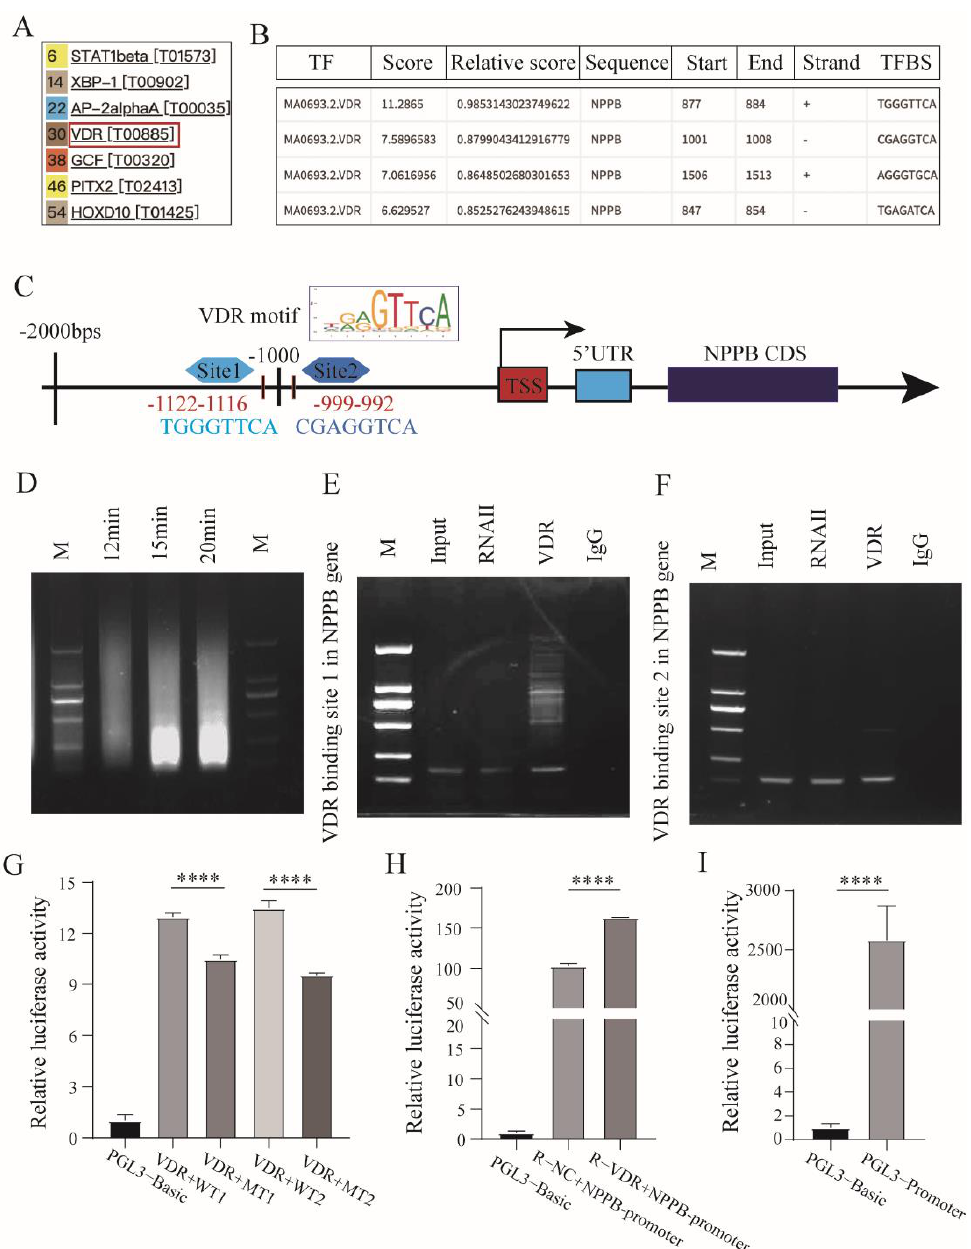
Figure 6. VDR binds to BNP promoters to regulate BNP gene expression. ( A ) Possible BNP binding transcription factors predicted by PROMO . ( B ) Predicted VDR binding sites in human BNP(NPPB) gene promoter regions. Human NPPB gene upstream regions were analyzed for VDR binding sites by JASPAR online analysis (http://jaspar.genereg.net, accessed on 14 April 2021). ( C ) Schematic diagram of predicted VDR binding sequences within a region 999 bp and 1122 upstream of the BNP gene locus TSS. ( D ) DNA fragments were obtained after different times of ultrasound before ChIP assays. ( E , F ) ChIP assays were performed to determine the binding of VDR to the BNP promoter region in 293 T cells. The two regions amplified by the specific PCR primers in ChIP assays are indicated. ( G – I ) Luciferase activity assays were conducted to assess the interaction between NPPB gene promoter regions and transcription factor VDR in human 293 T cells and rats. Luciferase reporter plasmid containing NPPB promoter sequence (or blank sequence) were transinfected into the control cells or VDR expressed cells, luciferase activity was quantitatively analyzed. The data are presented as the mean ± SD, ****, p < 0.0001.